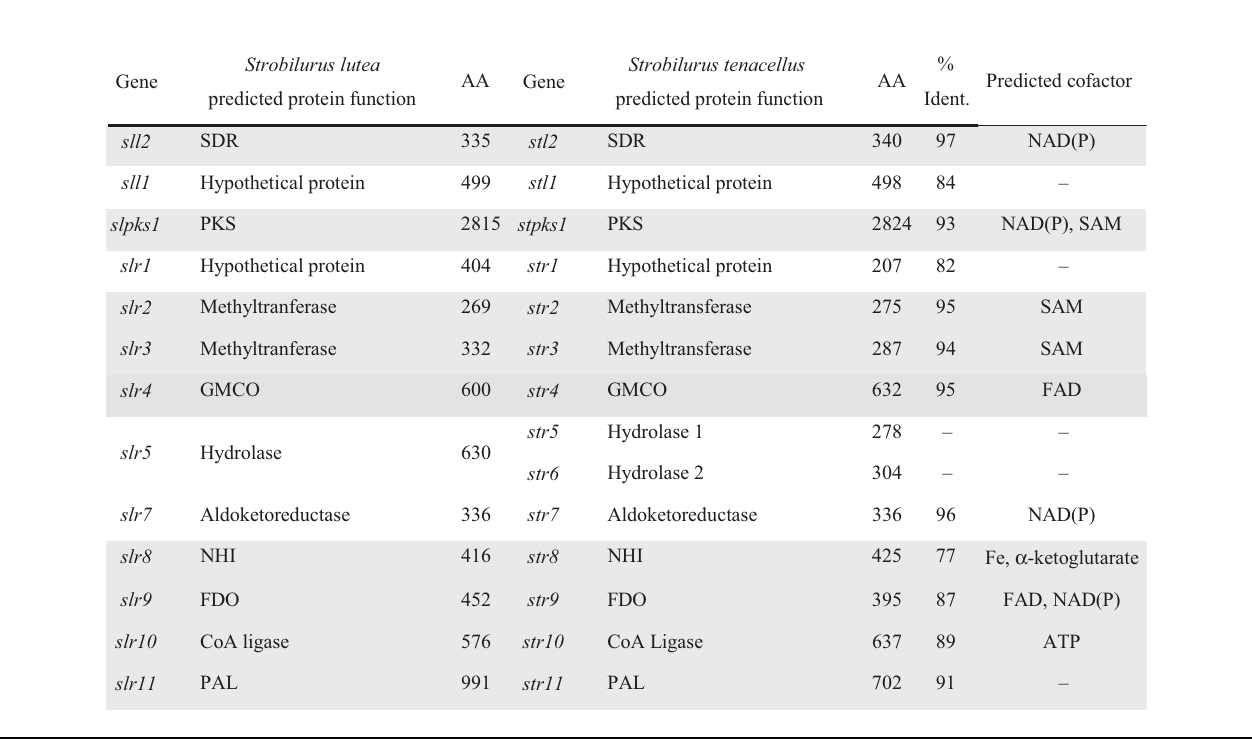
See Supplementary Table 5 for a full list of genes found on the entire contig. Shaded rows indicate genes shown to be involved in the biosynthesis of strobilurin or bolineol by heterologous expression. Predicted functions from NCBI-conserved domain